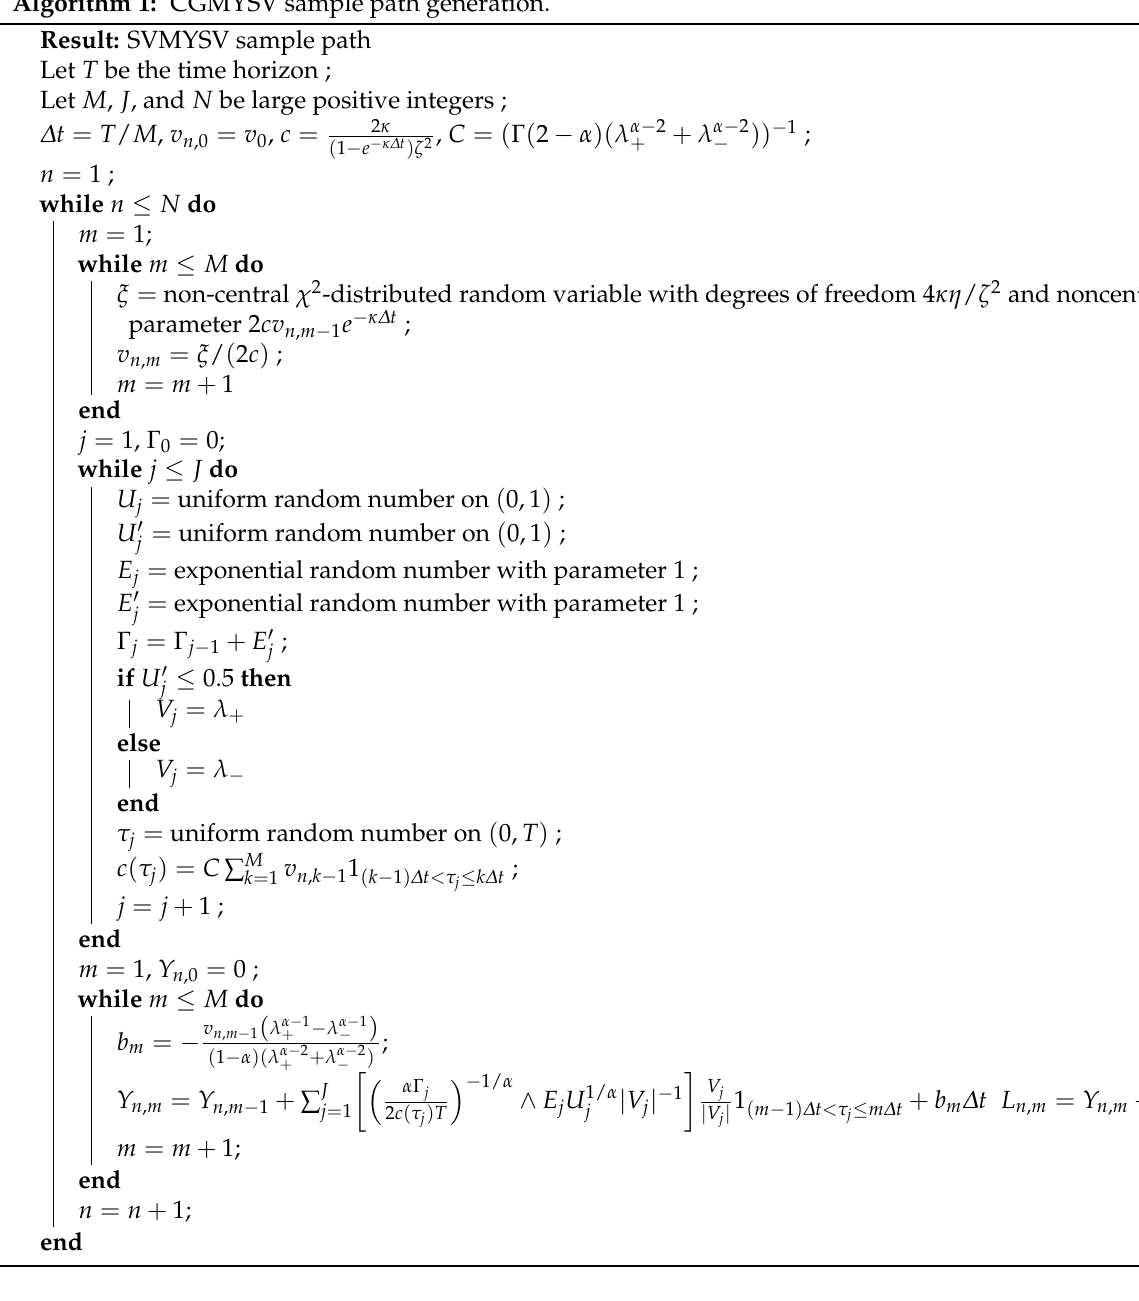
Algorithm 1: CGMYSV sample path generation.